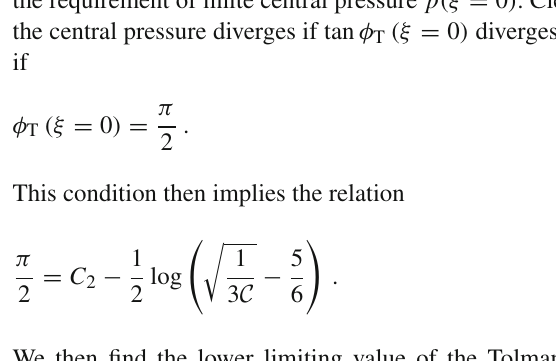
Fig. 1 EffectivepotentialsoftheTolmanVIIobjectswithinversecom- pactness R / M given in the